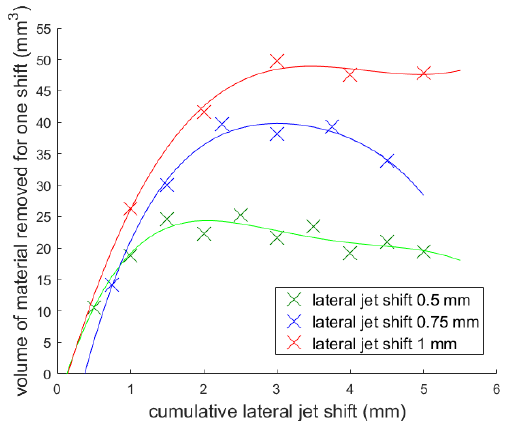
Figure 9. Dependence of the material removed on the jet cumulative lateral jet shift.